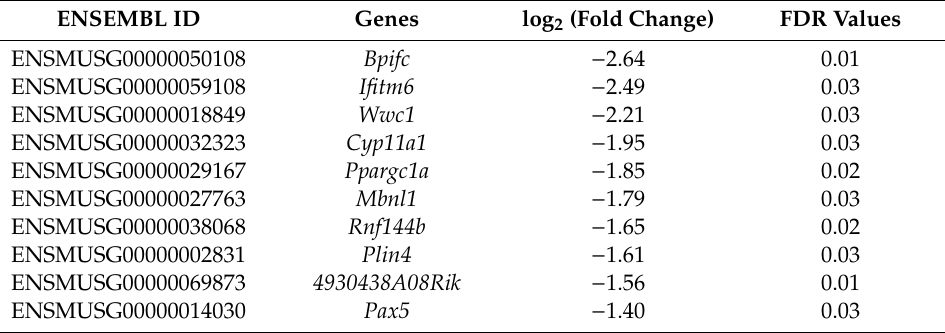
Figure 3. Effects of MBNL1 knockdown on the differentially expressed genes identification and Gene Ontology (GO) annotation in C2C12 myotubes. Heatmap ( A ) and GO annotation ( B ) of the differentially expressed genes (DEGs). Table 1. MBNL1 knockdown-associated downregulated genes with the rate of variability in C2C12 myotube.